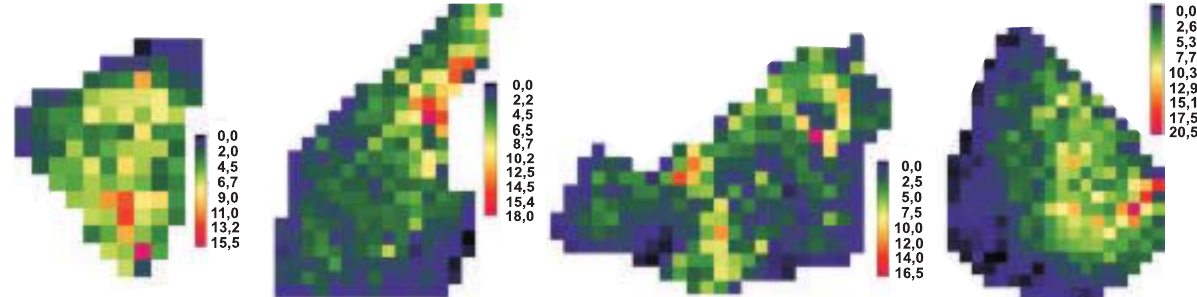
Figura 2. Fator LS calculado pelo método de Desmet & Govers (1996) para as quatro bacias.